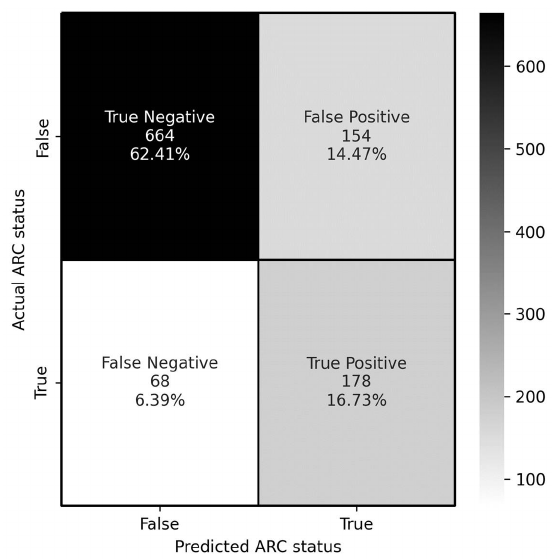
Figure 3. Confusion matrix with numbers and percentages of ICU days with true/false posi- tives/negatives. ARC, augmented renal clearance.